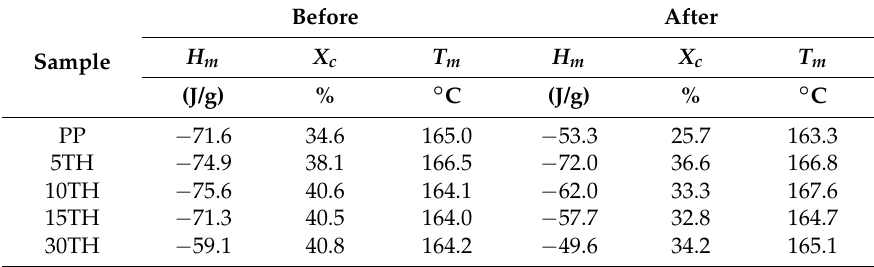
Table 1. Crystallinity of PP and PP/TH composites before and after UV accelerated weathering.